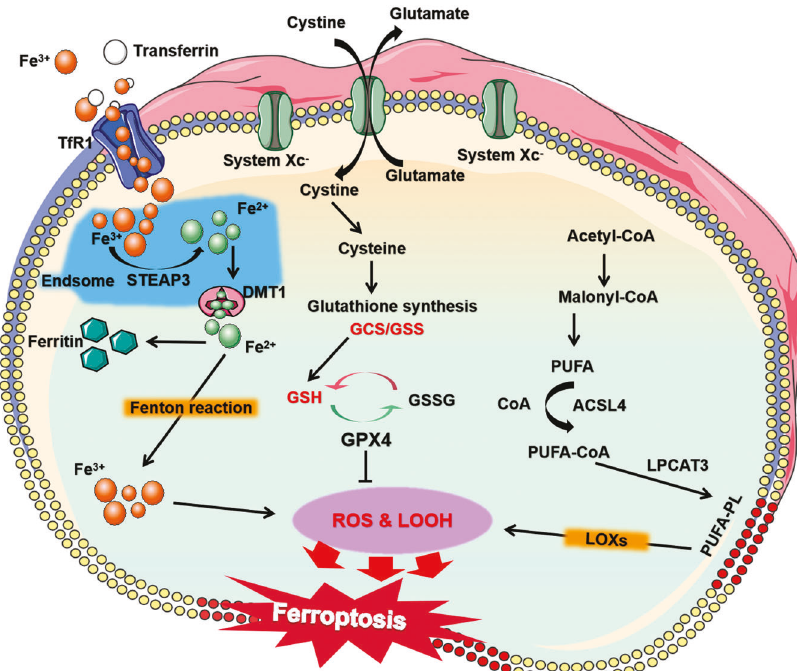
Fig. 1 The mechanisms of ferroptosis. Ferroptosis is caused by excessive accumulation of lipid peroxide, ROS production and abnormal iron metabolism. Excessive Fe 2 + accumulation will cause ROS production and lipid peroxidation. System Xc − can control the transport of cystine to cells and affect GPX4 activity. GPX4 is a key molecule for endogenous inhibition of lipid peroxidation. The arrows indicate promotion, and the blunt-ended lines indicate inhibition. STEAP3 six-transmembrane epithelial antigen of prostate 3, DMT1 divalent metal transporter 1, TfR1 transferrin receptor 1, GSSG glutathione disul fi de, ROS reactive oxygen species, LOOH lipid